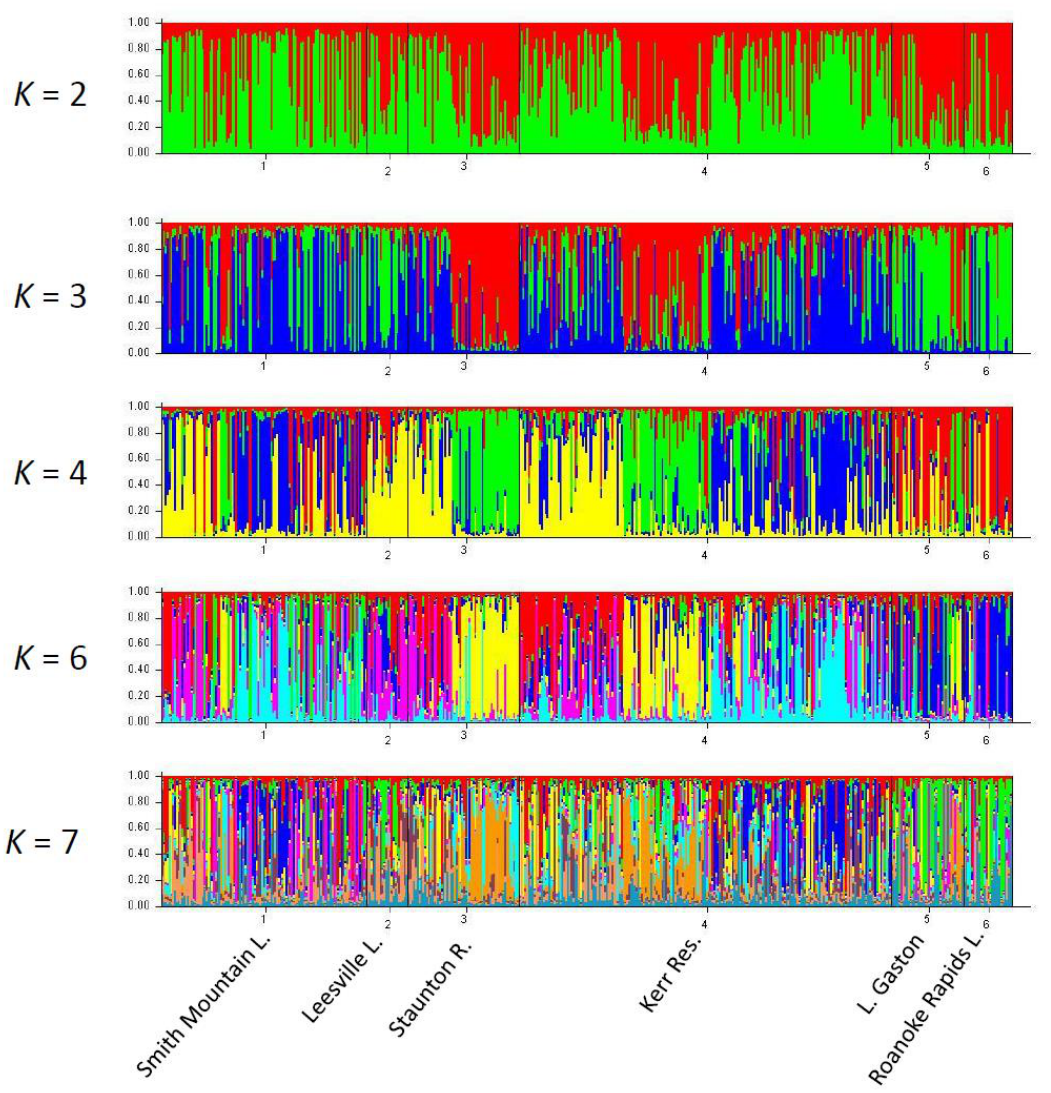
Figure 6. STRUCTURE plots representative of structuring of striped bass collections within the upper Roanoke River basin.